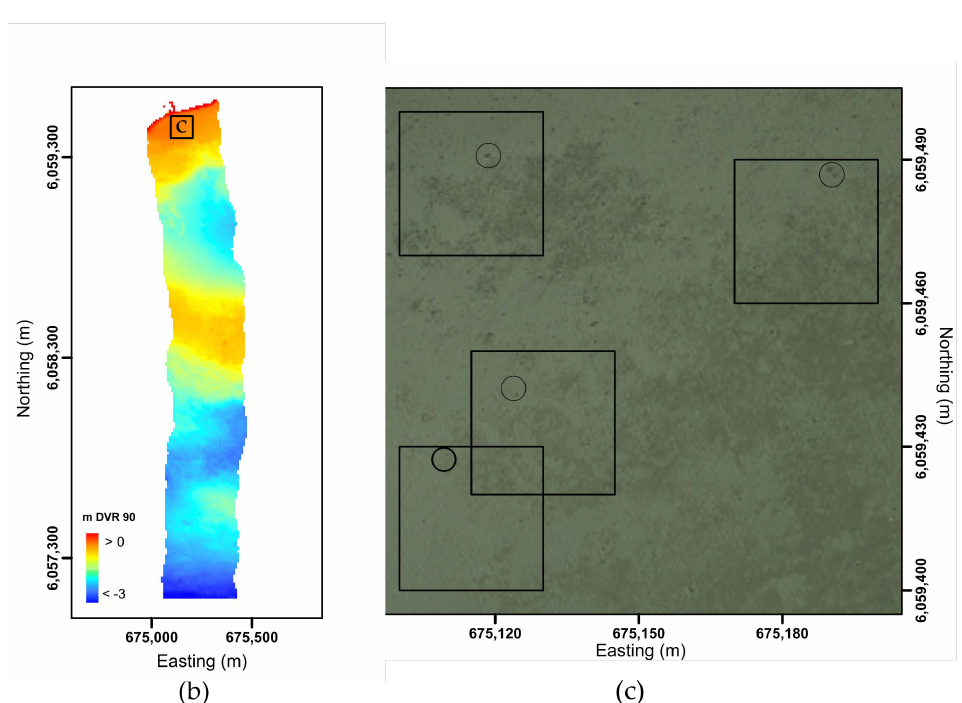
Figure 1. ( a ) Rødsand lagoon with flight lines (green lines). ( b ) DEM of the 400 × 2500 m study area with 10 m × 10 m resolution; square is the area in ( c ); ( c ) Orthophoto with squares (30 m × 30 m areas) including boulders (circles). Image ( a ) are Copernicus Sentinel data 2021, processed by ESA, Esri, DigitalGlobe, GeoEye, i-cubed, USDA FSA, USGS, AEX, Getmapping, Aerogrid, IGN, IGP, swisstopo, and the GIS User Community. Ortho photo ( c ) is supplied by Danish Agency for Data Supply and Infrastructure. Projection is in ETRS89 UTM Zone